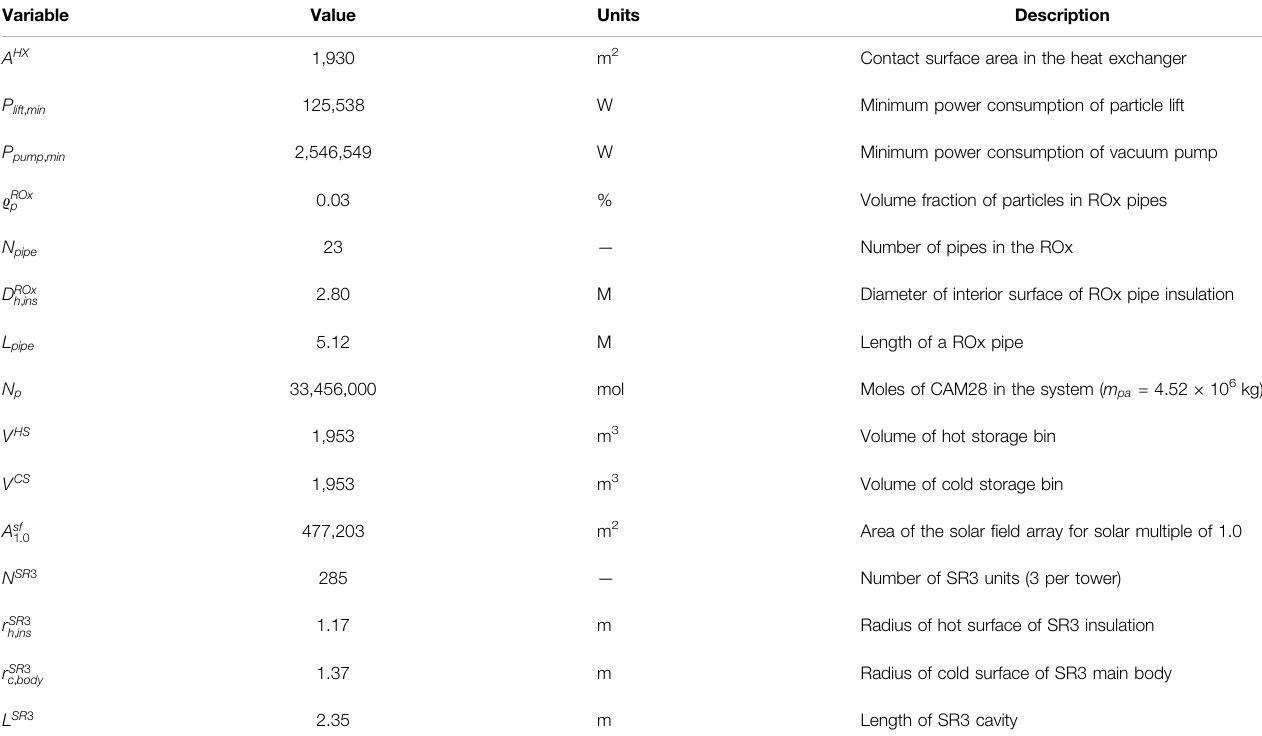
TABLE 8 | Component sizing